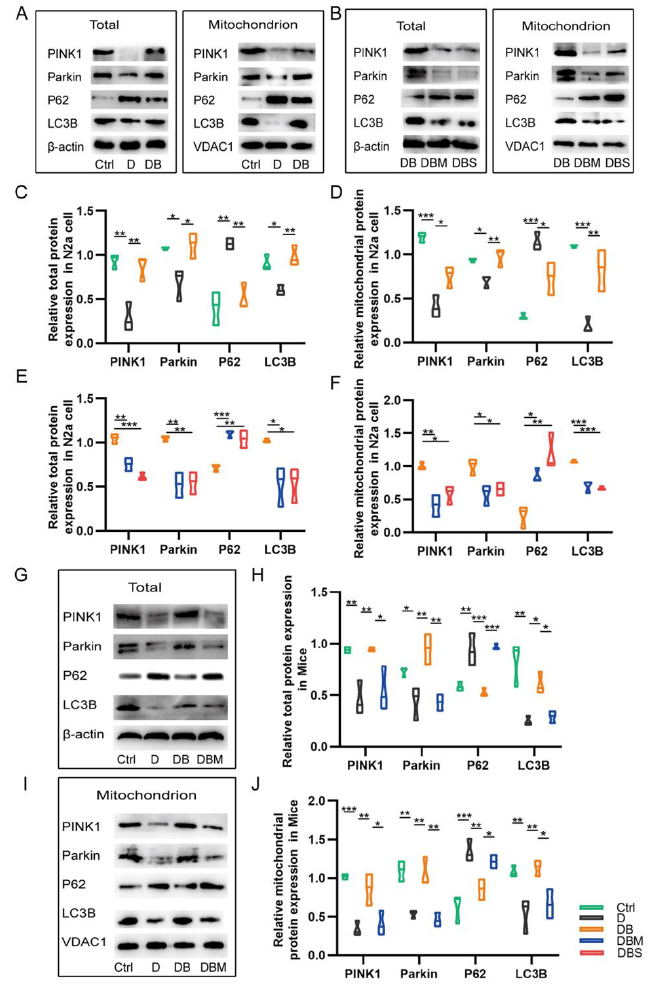
Figure 3. Berberine regulates the protein expression of PINK1–Parkin pathway proteins. D-ribose decreased the expression of key mitophagy-associated proteins PINK1, Parkin, and LC3B, both in vitro ( A – F ) and in vivo ( G – J ). Representative Western blot images and quantification of PINK1, Parkin, P62, and LC3B protein in N2a cells ( A – F ). Relative quantification of protein expression in APP/PS1 mice by Western Blot ( G – J ). * p < 0.05, ** p < 0.01, *** p < 0.001. Abbreviation: Ctrl, Control; D, D-ribose; DB, D-ribose + BBR; DBM, D-ribose + BBR + Mdivi-1; DBS, D-ribose + BBR + si-PINK1.